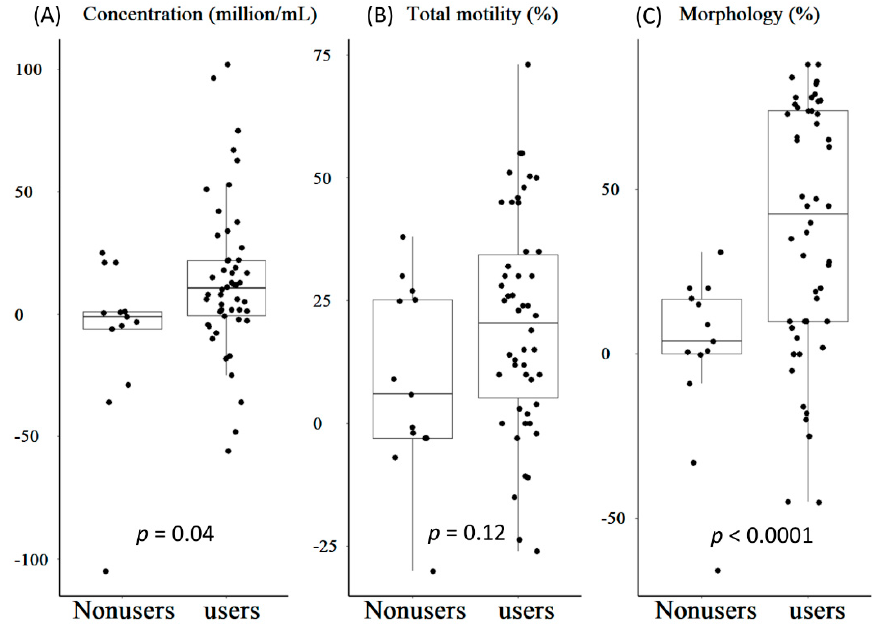
Figure 2. The changed value of semen parameter and linear regression analysis for changed value between TCM users and nonusers. ( A ) Concentration; ( B ) Total motility; ( C ) Morphology.